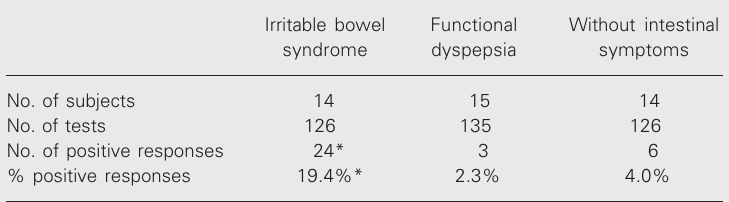
Table 1. Responses of patients with irritable bowel syndrome to the food antigen prick